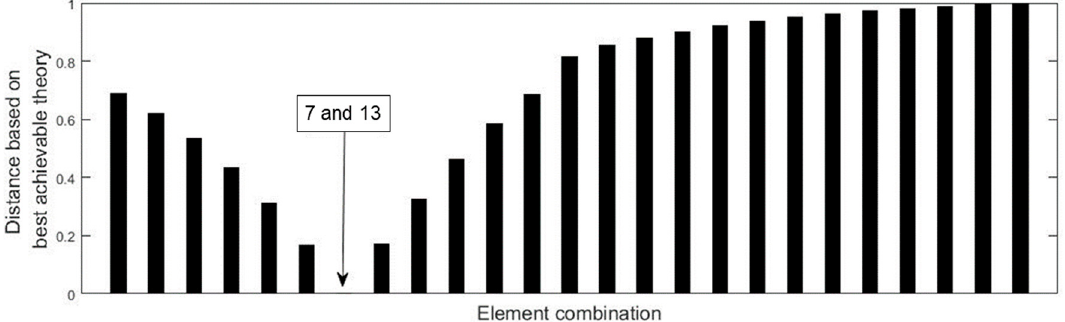
Figure 3. The distance δ (cid:48) ' ( i = 1 ∼ 26) for each component when element 13 is damaged (3% noise).